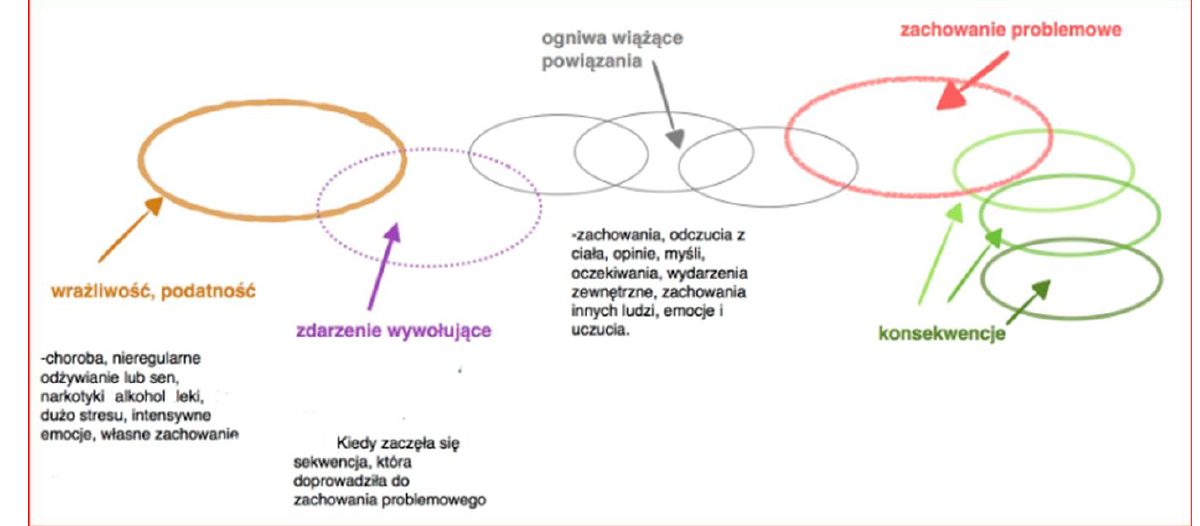
Figure 1. Behavioral Chain Analysis Method by which dialectical behavioral therapy was performed in a